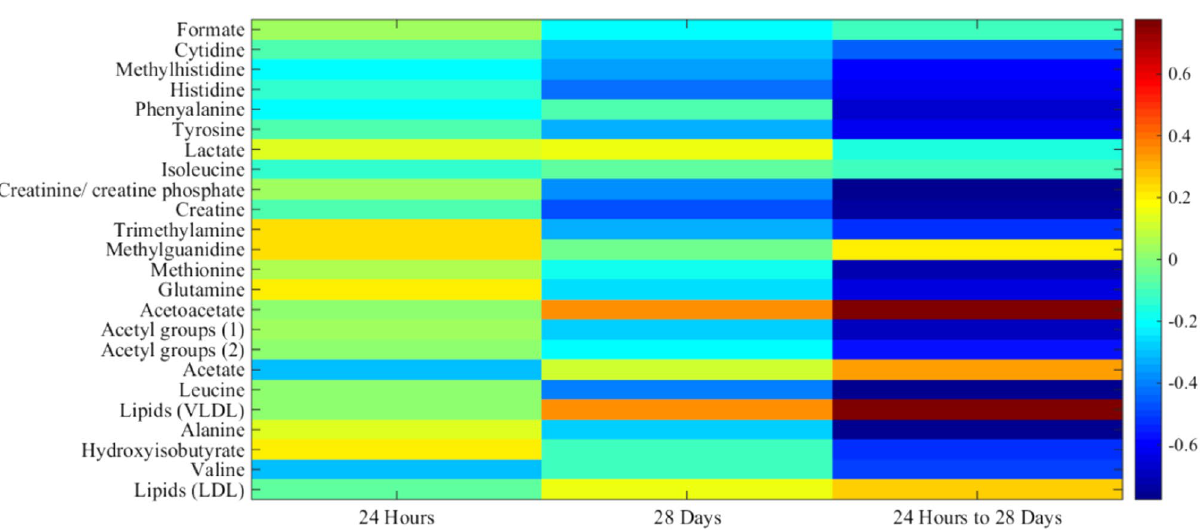
Figure 8. Heat map depicting the correlations (R 2 values) of major endogenous metabolites measured in rat serum by 1 H NMR using a Carr-Purcell-Meiboom-Gill (CPMG) spin echo sequence experiments with procedure type. The first column displays correlations for the vehicle/IR animals relative to sham-operated controls at 24 h post-surgery; the second column displays correlations between the vehicle/IR animals and sham-operated controls at 4 weeks (28 days) post-surgery, with hot (e.g. red) colors denoting a positive correlation for the IR cohort. The final column displays correlations between the vehicle/IR animals at 4 weeks (28 days) relative to 24 h post-surgery, with hot colors (e.g. red) denoting a positive